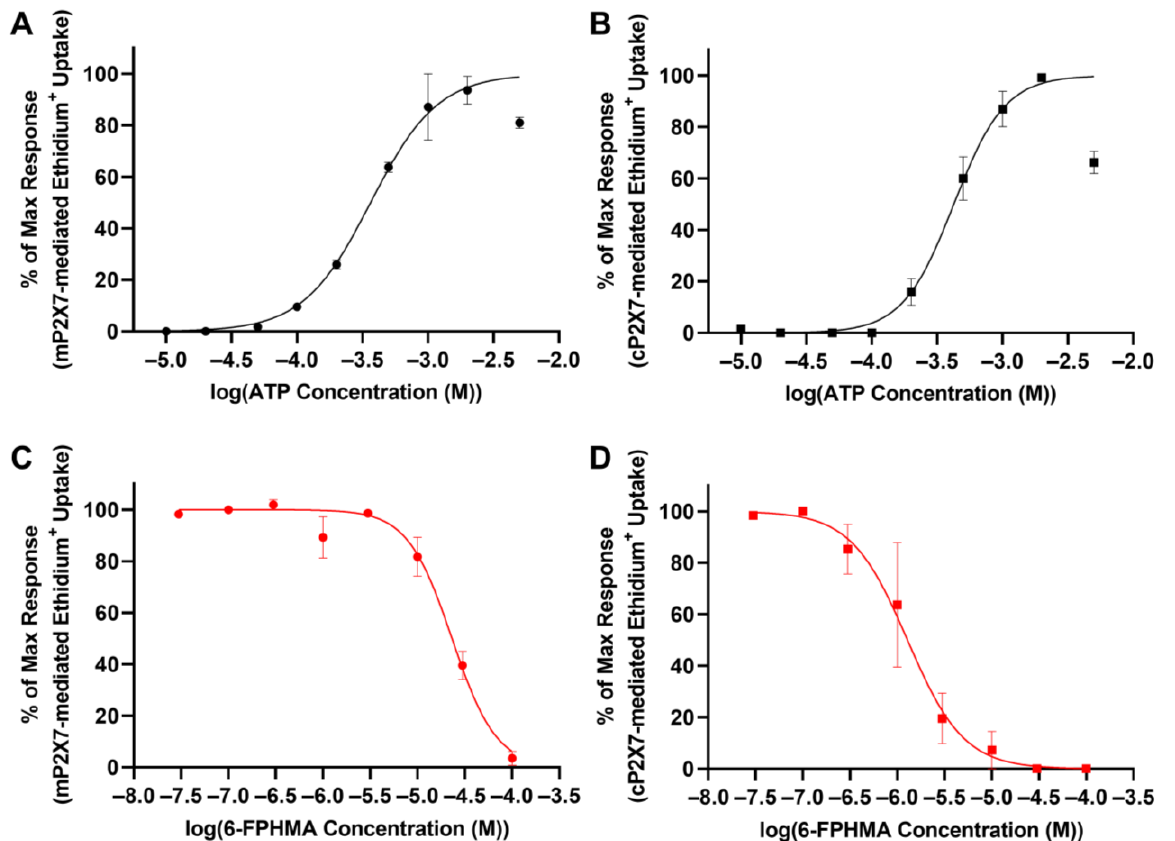
Figure 4. 6-FPHMA inhibits murine (m) and canine (c) P2X7 in a concentration-dependent manner. HEK293 cells were transfected with ( A , C ) mP2X7-green fluorescent protein (GFP) or ( B , D ) cP2X7-GFP and pre-incubated ( A , B ) alone (5 min) or ( C , D ) with 6-FPHMA at the concentrations indicated (15 min). Cells were incubated with ethidium + in the absence (basal) or presence of ATP at ( A , B ) the concentrations indicated, ( C ) 360 μM or ( D ) 420 μM (5 min). ( A – D ) Ethidium + uptakes in GFP + cells were assessed by flow cytometry and data normalised to the maximum ATP response in each experiment. ( A – D ) Data presented as mean ± SEM. ( A – D ) n = 3 independent experiments.